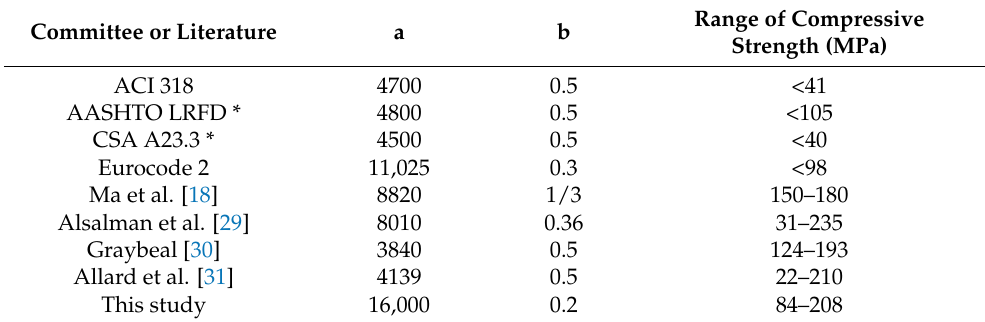
Table 6. Coefficient of Equation (14) for the proposed equations for MOEs.